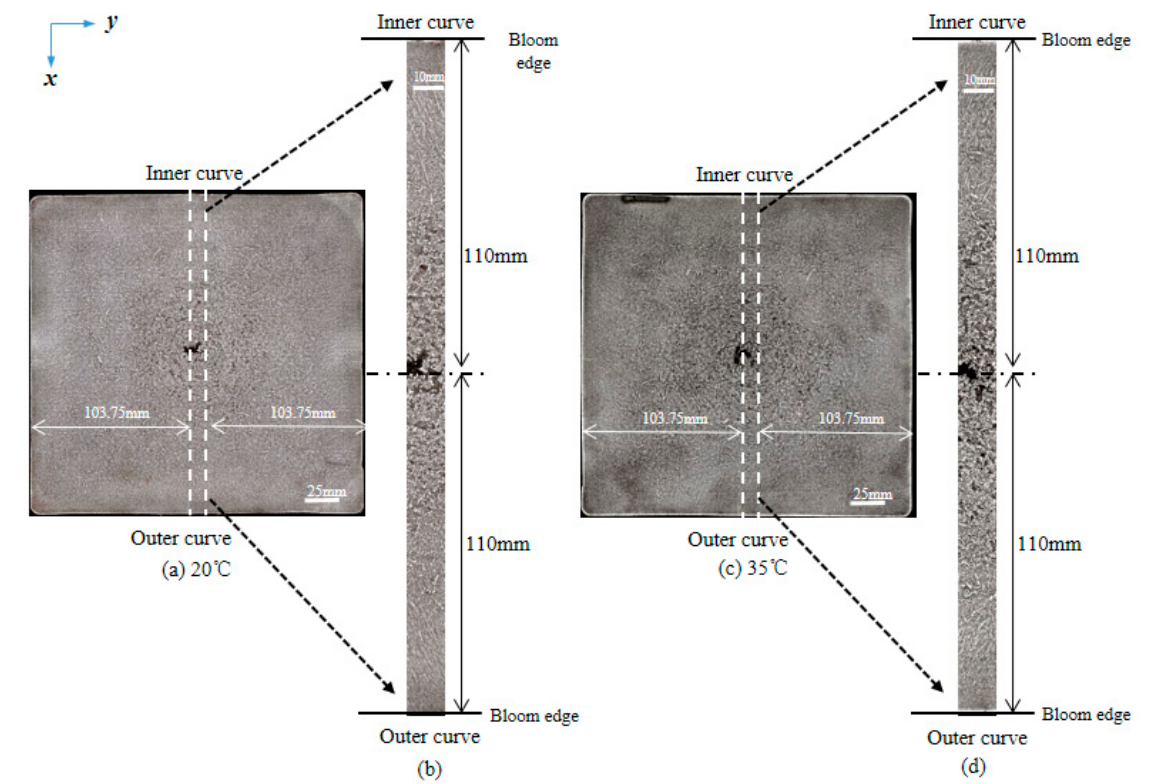
Figure 2. Macrostructure of GCr15 steel bloom sample: ( a ) whole etched surface at 20 °C (220 mm × 220 mm); ( b ) measured etched surface at 20 °C (12.5 mm × 220 mm); ( c ) whole etched surface at 35 °C (220 mm × 220 mm); ( d ) measured etched surface at 35 °C (12.5 mm × 220 mm). Table 1. Main continuous casting process parameters of GCr15 steel bloom.